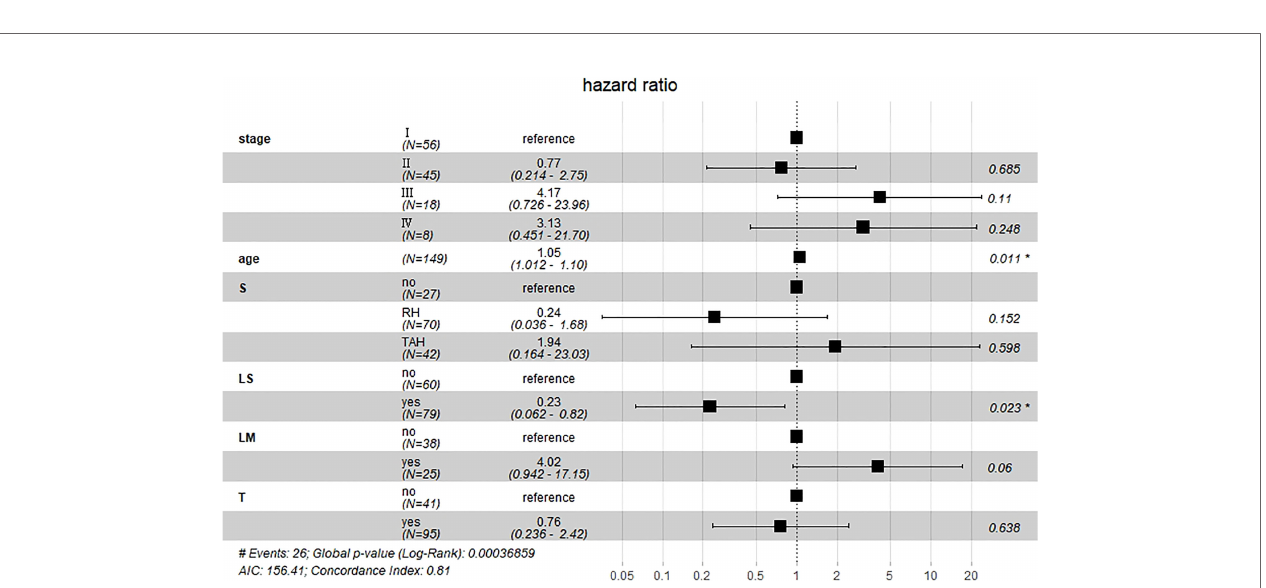
FIGURE 13 | Multivariate Cox hazard model analysis for all patients. Age, stage III&IV, TAH, and lymph metastasis increased the risk of death, whereas RH and lymphadenectomy was associated with reduced risk of death. *means